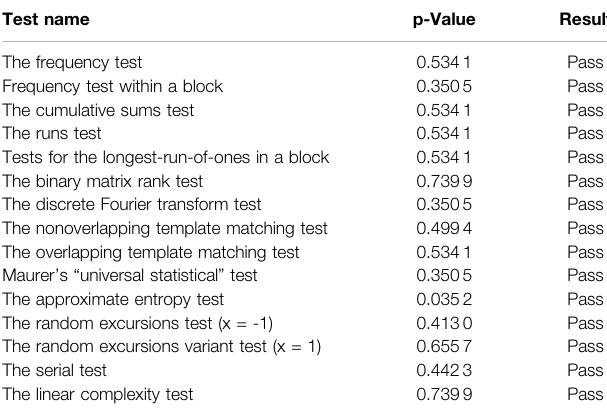
TABLE 2 | Statistical table of the results of testing the randomness of random sequences using NIST SP800-22 Test name